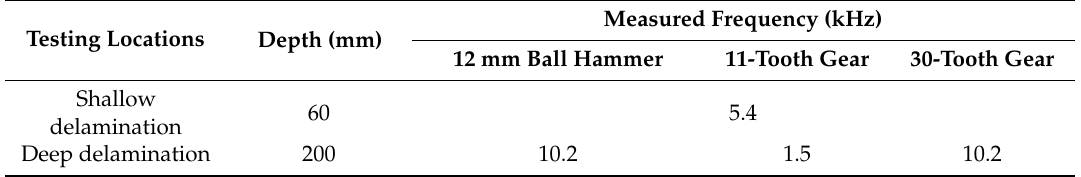
Table 2. Results of obtained frequency.